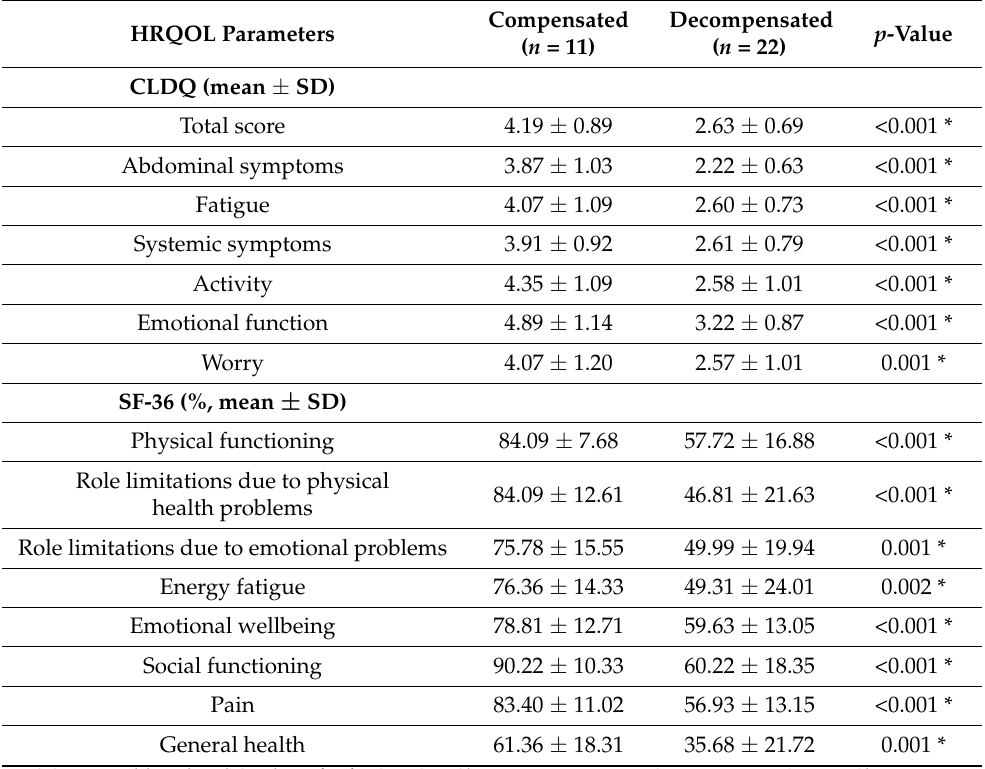
Table 7. Assessment of HRQOL among patients with